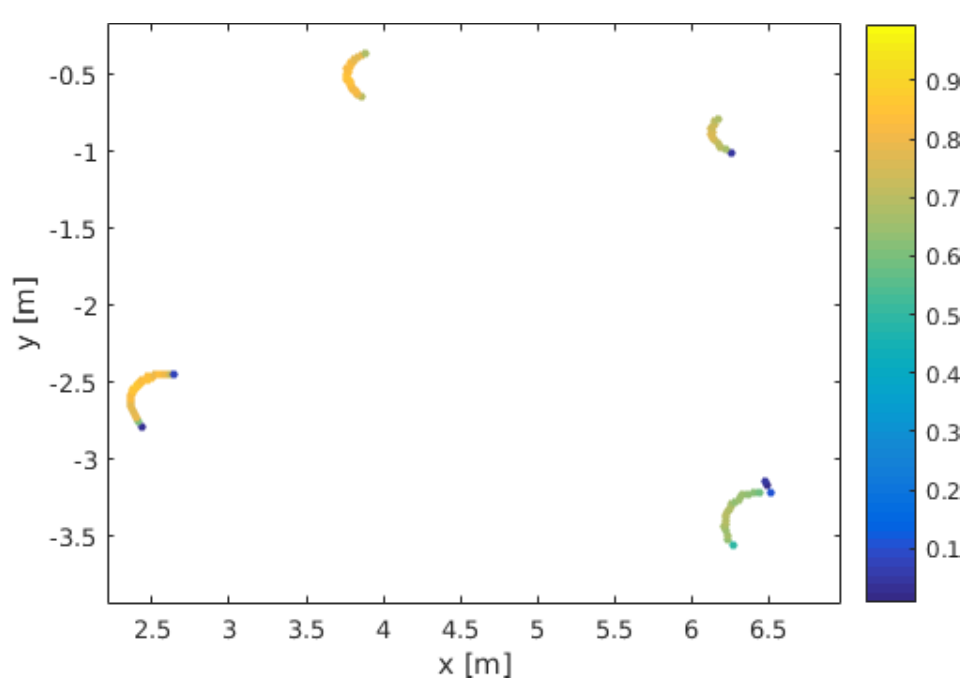
Figure 8. Four stem point clusters from one line of SICK data after 3D calculation projected on the ground plane. The points are colored according to normalized intensity. The endpoints of the clusters based on distance criterion have lower intensity